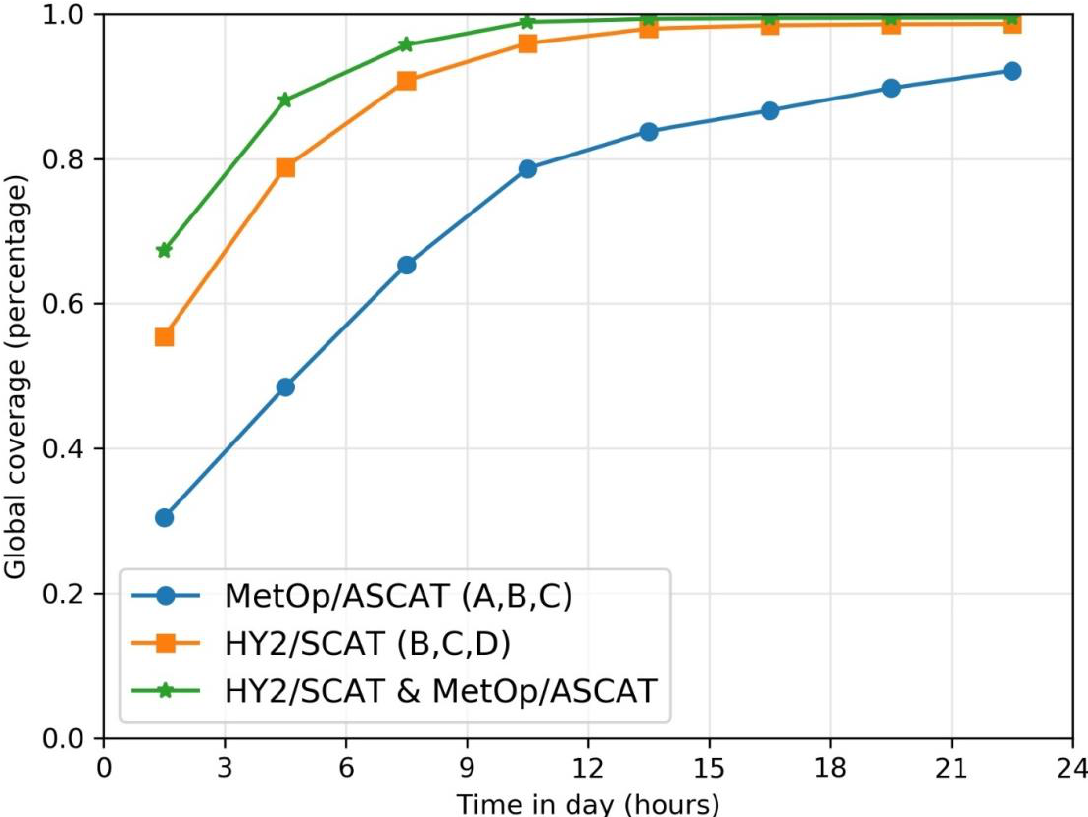
Figure 1. Global sea-area coverage of the dynamic satellite constellation scatterometer.